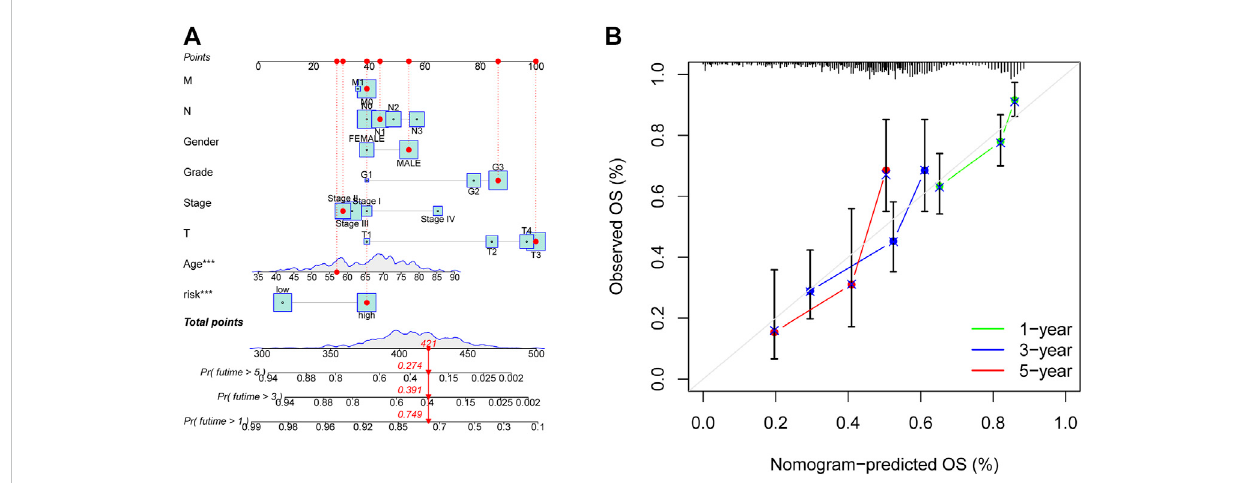
FIGURE 7 Nomogram for anticipating OS in GC patients. (A) Nomogram of prognostic models and clinicopathological factors founded on 11 AMMLs. (B) Performance of the nomogram model determined by the calibration curve. The ideal nomogram is shown as the diagonal dotted grey line. * p < 0.05, ** p < 0.01; *** p < 0.001. OS, overall survival; GC, gastric cancer; AMMLs, Amino acid metabolism-related